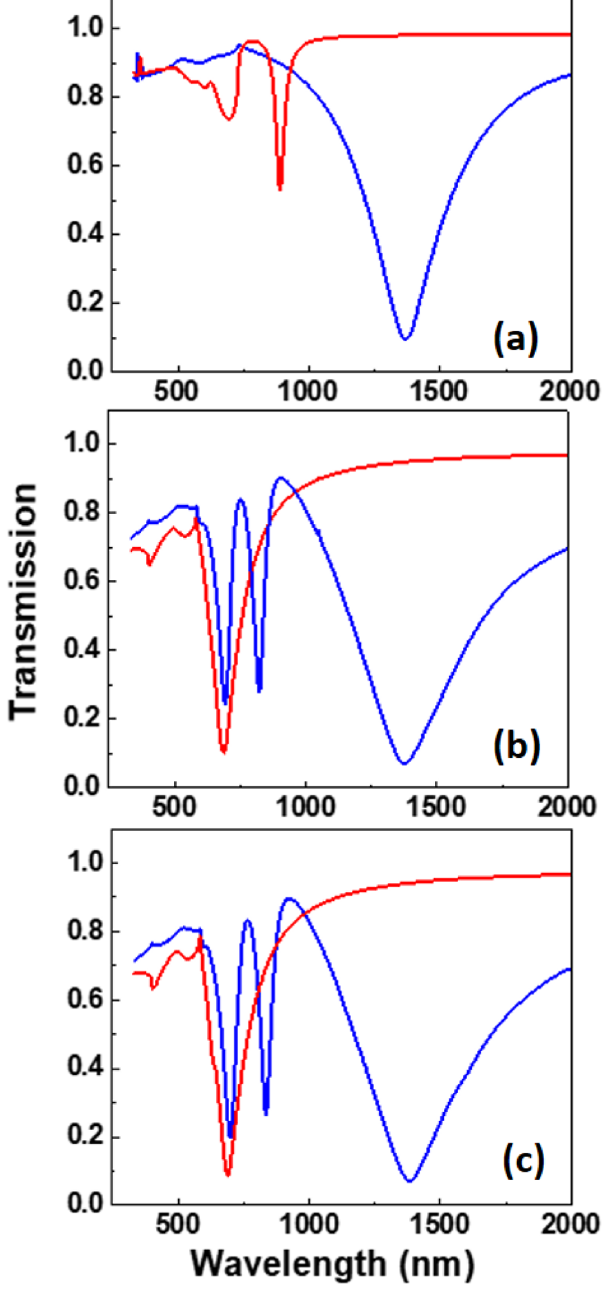
Fig. 3. Calculated transmission spectra for y -polarized (red) and x -polarized (blue) lights for (a) Triangle, (b) SRR and (c) Heptagon structures.